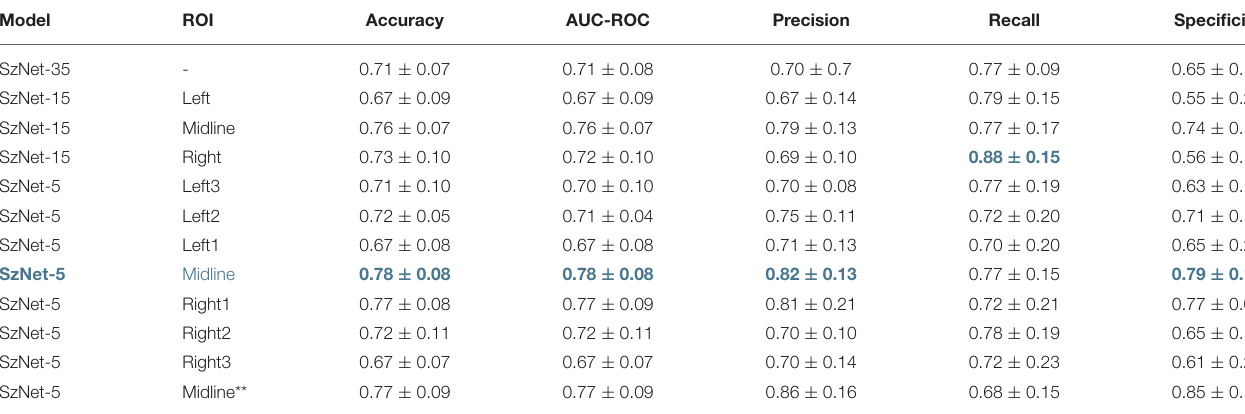
TABLE 2 | Performance of the models tested (SzNet-5, SzNet-15 and SzNet-35) using different spatial ROI evaluated with five metrics: accuracy; AUC-ROC; precision; recall; and specificity. Model ROI Accuracy AUC-ROC Precision Recall Specificity